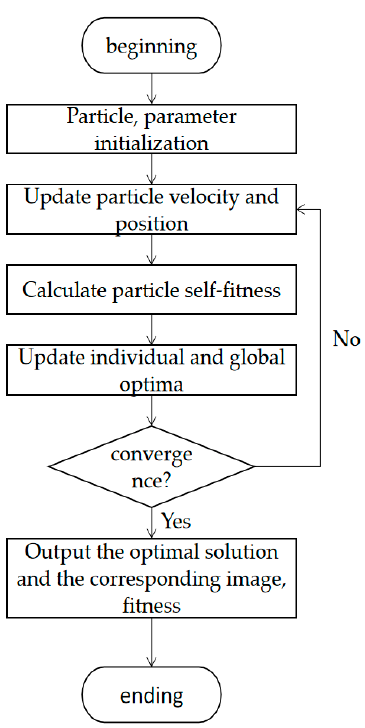
Figure 12. A flow chart for the adaptive log-Gabor function.